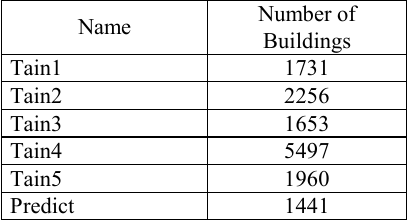
Table 1 . The number of buildings involved in training and